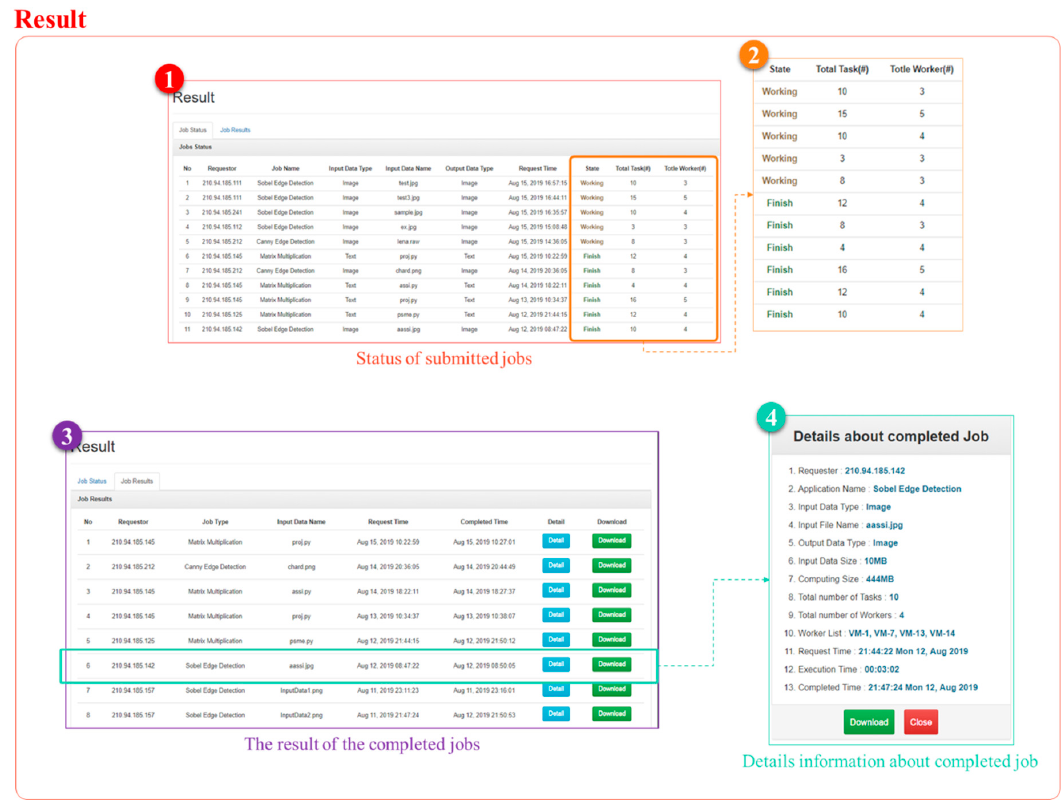
Figure 9. Result view to provide detailed information to the requester.